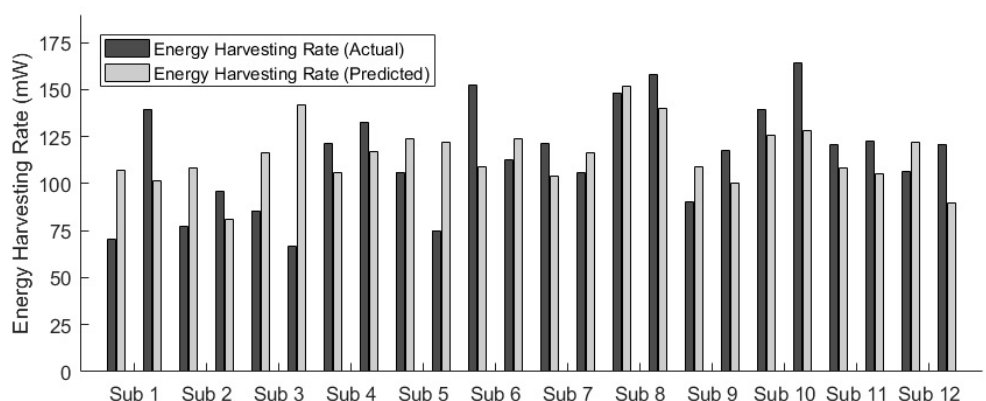
Figure 5. Energy harvesting rate modeling results across individuals. The trend of the predicted energy harvesting rates in general followed that of the actual energy harvesting rates across individual subjects. Average absolute and percent errors for the energy harvesting rate model were 24.6 mW and 24.9%, respectively. For the extended energy harvesting model, which included the additional average generator maximum voltage per step feature, the average absolute and percent errors were 15.1 mW and 13.8%, respectively.